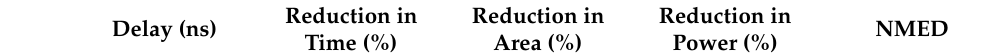
Table 5. Adder testing results in full prediction configuration.